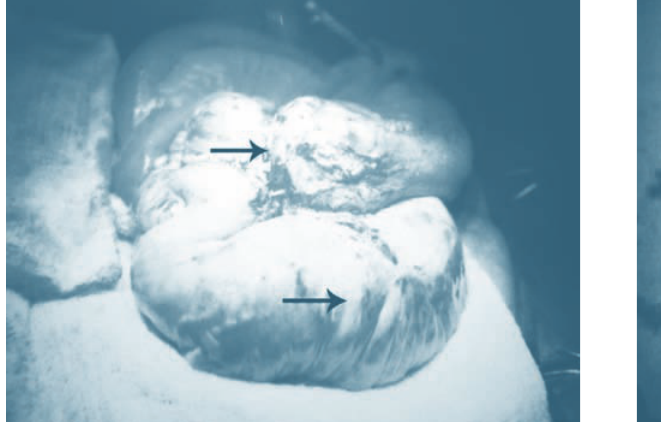
Figure 2. The Loop of bowel opened with the surgical sponge exposed with fistulous